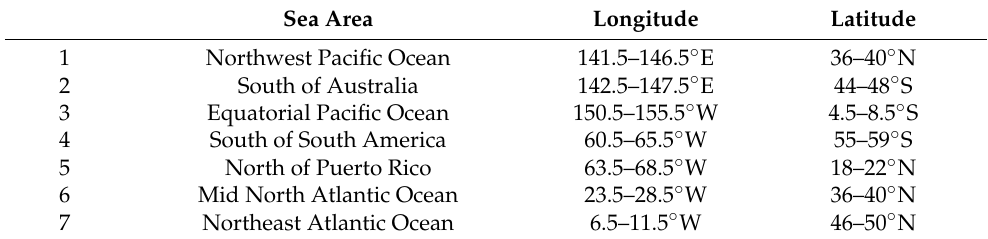
Table 6. Spatial extent of seven typical sea areas.